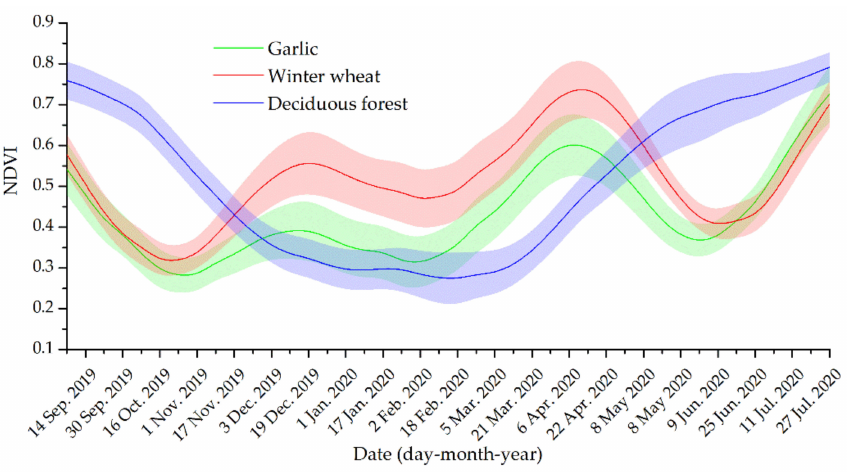
Figure 3. Moderate resolution imaging spectroradiometer (MODIS) normalized di ff erence vegetation index (NDVI) time series curves for di ff erent vegetation (i.e., garlic, winter wheat, and deciduous forest) in the study area from 6 September 2019 to 27 July 2020. The curves represent the mean NDVI value based on the samples. The background color represents the standard deviation for each type of vegetation NDVI